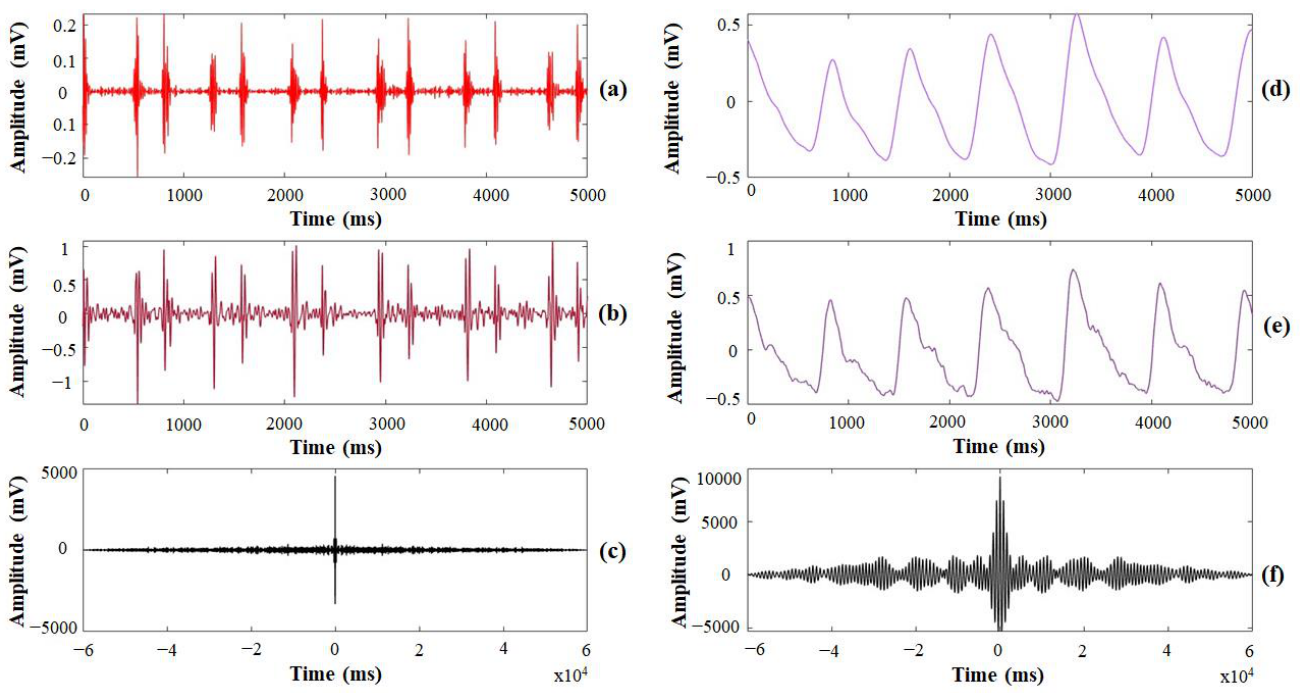
Figure 10. An example of the heart sounds and PPG signals measured by the prototype device and the MP160: ( a ) PCG signal detected by the prototype device; ( b ) PCG signal detected by the MP160; ( c ) cross-correlation results of the PCG signal comparison; ( d ) PPG signal detected by the prototype device; ( e ) PPG signal detected by the MP160; ( f ) cross-correlation results of the PPG signals comparison. Table 1. Cross-correlation values for heart sounds and PPG signals measured by the prototype de- vice and the MP160.